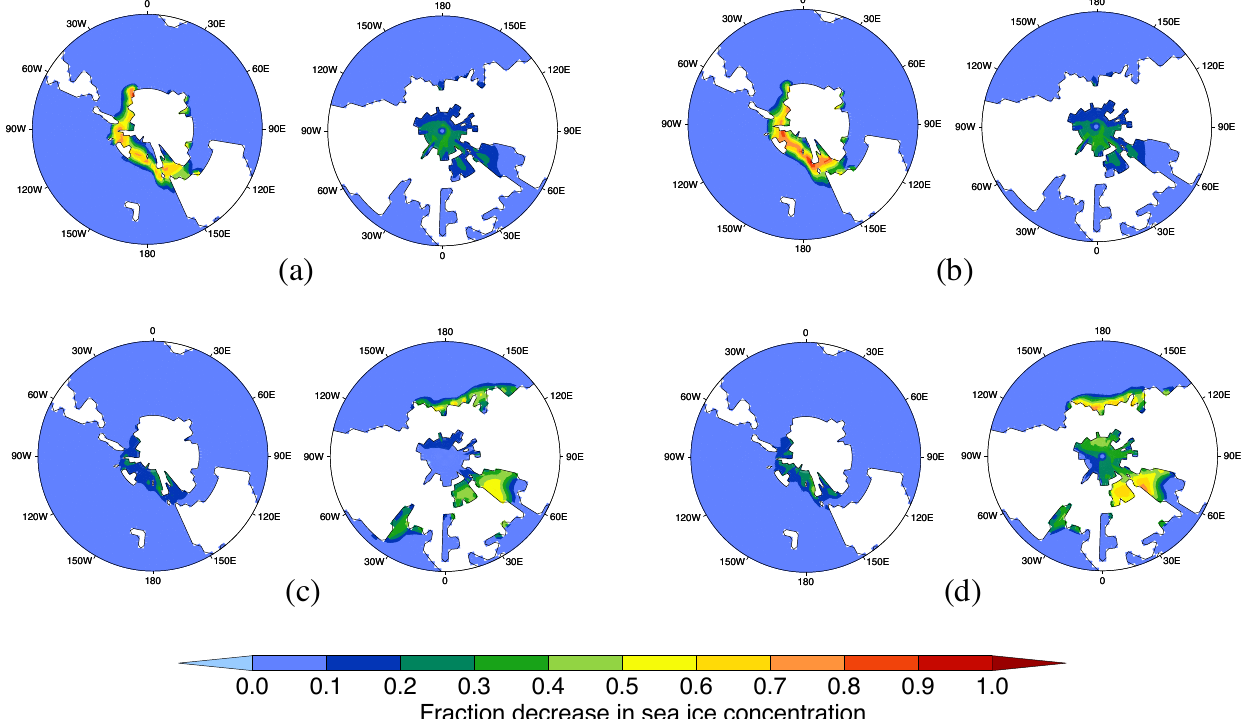
Fig. 7. Fractional reduction in sea ice concentration when CO 2 is doubled in (a) SHRUB simulations in JJA, (b) DYN simulations in JJA, (c) SHRUB simulations in DJF, and (d) DYN simulations in DJF in the Southern Hemisphere (left panels) and Northern Hemisphere (right panels).